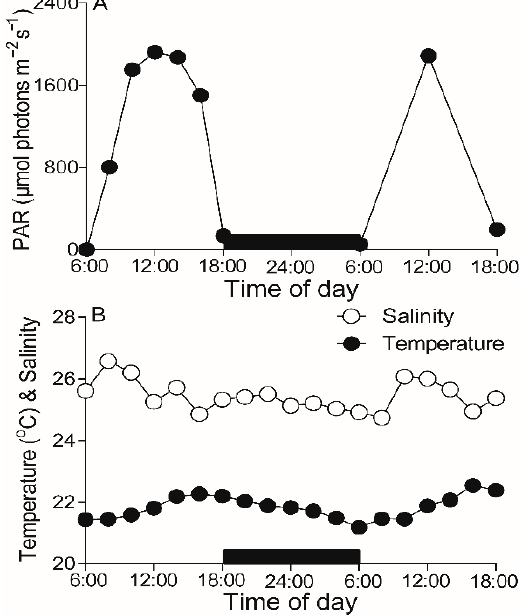
Figure 1. Daily changes of ( A ) atmospheric solar PAR irradiance (µmol photons m − 2 s − 1 ) and ( B ) temperature (°C) and salinity in sampling location during 25–26 March 2021.